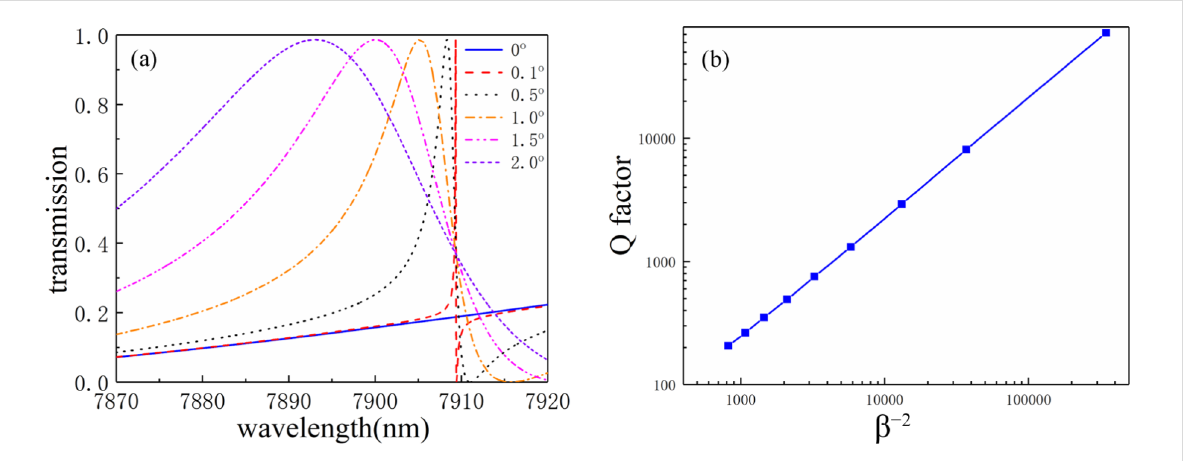
Figure 4: (a) Simulated zero-order transmission spectra of the structures without graphene monolayer for angles of 0°, 0.1°, 0.5°, 1.0°, 1.5°, and 2.0°; (b) dependence of the Q-factor on the inverse square of the asymmetric parameter β − 2 (log–log scale).